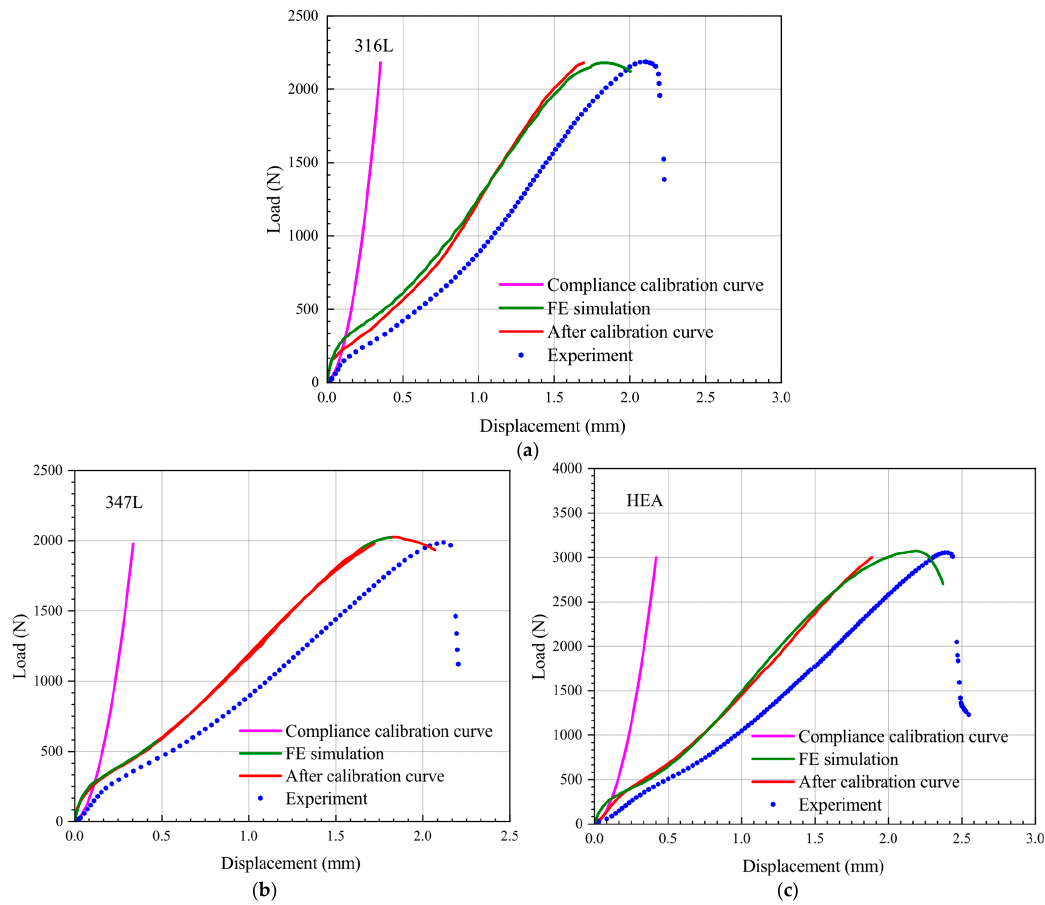
Figure 11. force–displacement curve of SPT before and after compliance correction. (a) 316L; (b) Figure 11. Force–displacement curve of SPT before and after compliance correction. ( a ) 316L; ( b ) 347L; (c) HEA.